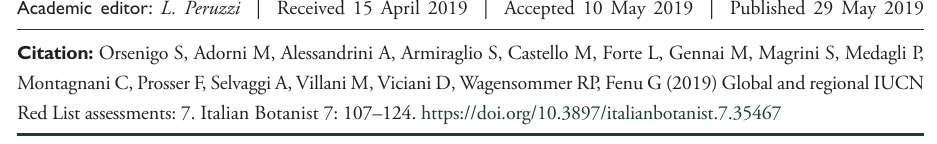
conservation, extinction risk, IUCN protocol,